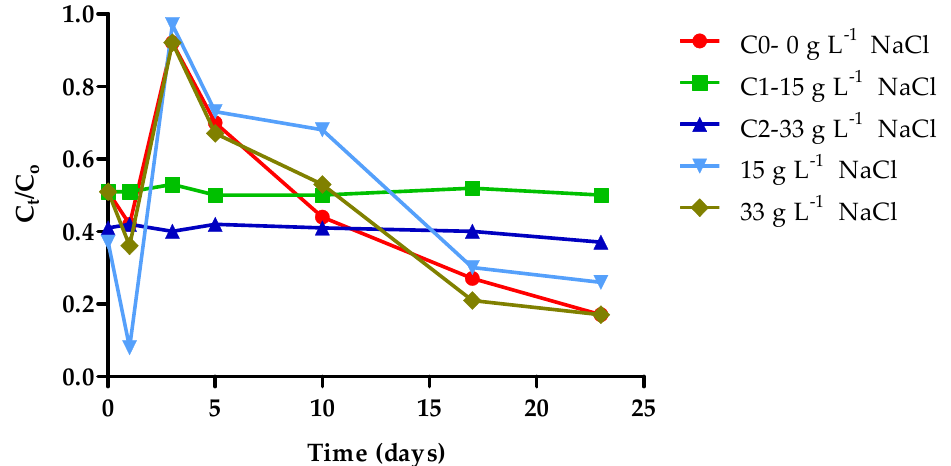
Figure 2. Biodegradation of phenanthrene (C 0 = 150 mg L − 1 ) over time by Citrobacter sp. D2 under different salinity conditions.